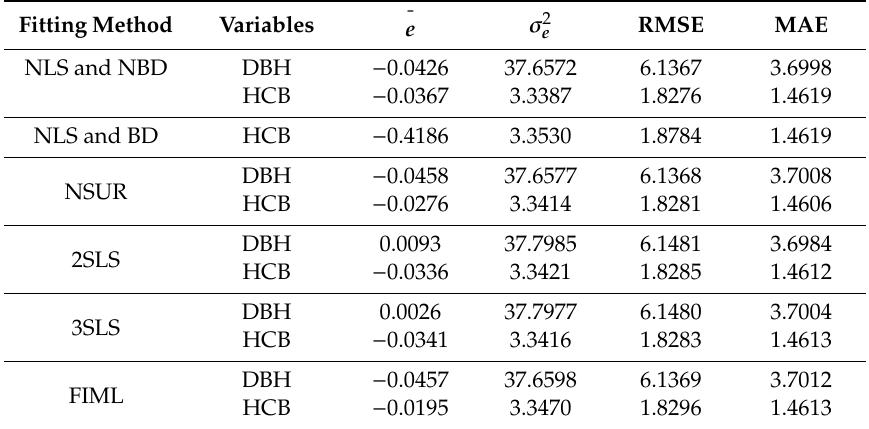
Table 3. Prediction statistics of the models: the DBH-based model (Equation (1)), the HCB-based model (Equation (2)) fitted with NLS, the HCB based on DBH model (Equation (13)) fitted with NLS, and the simultaneous equation system (Equation (3)) fitted with the NSUR, 2SLS regression, 3SLS regression, and FIML algorithms.(e, mean bias; σ 2 e , bias variance; and RMSE , root mean square error. All other acronyms are the same as defined in Table 2).